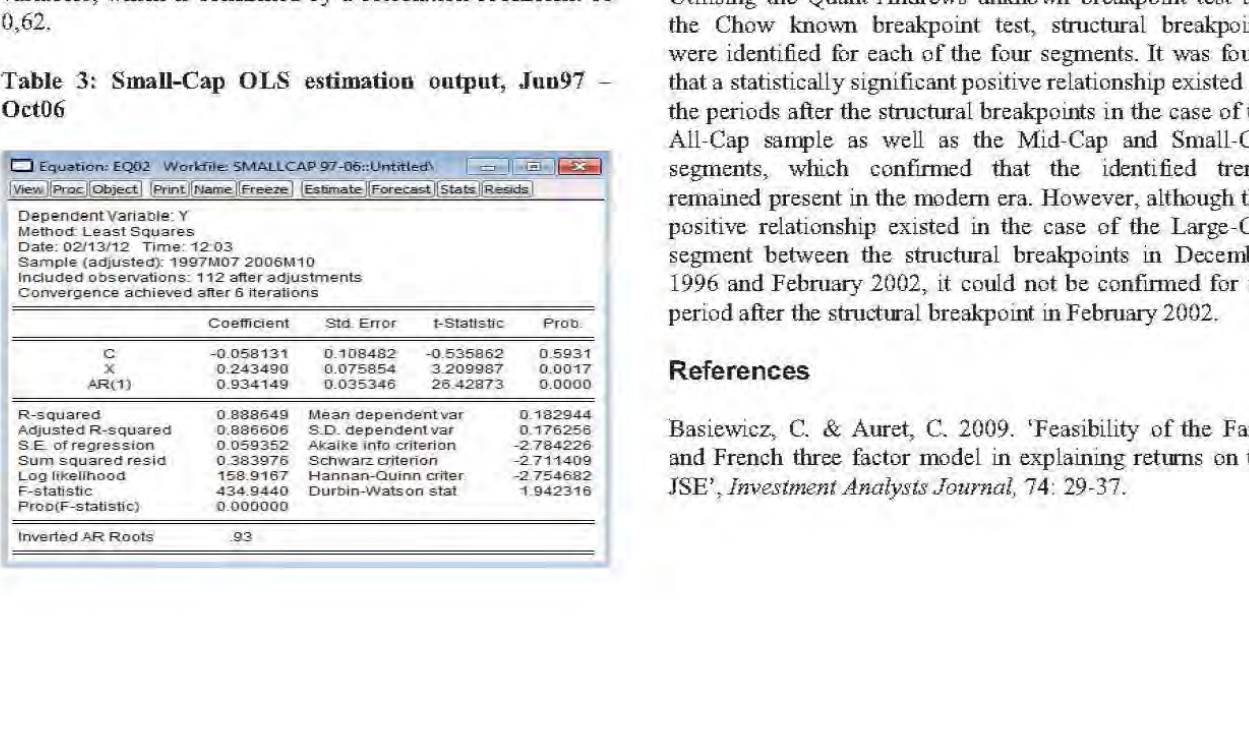
Table 3: Small-Cap OLS estimation output, Jun97 -